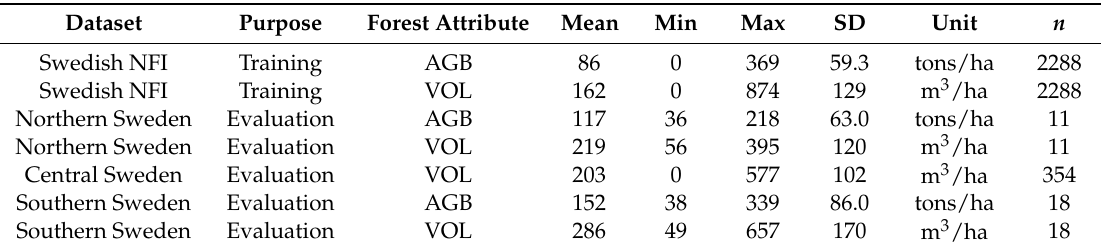
Table 1. Forest attributes for the field datasets. n denotes the number of stands or plots, and standard deviation is denoted as